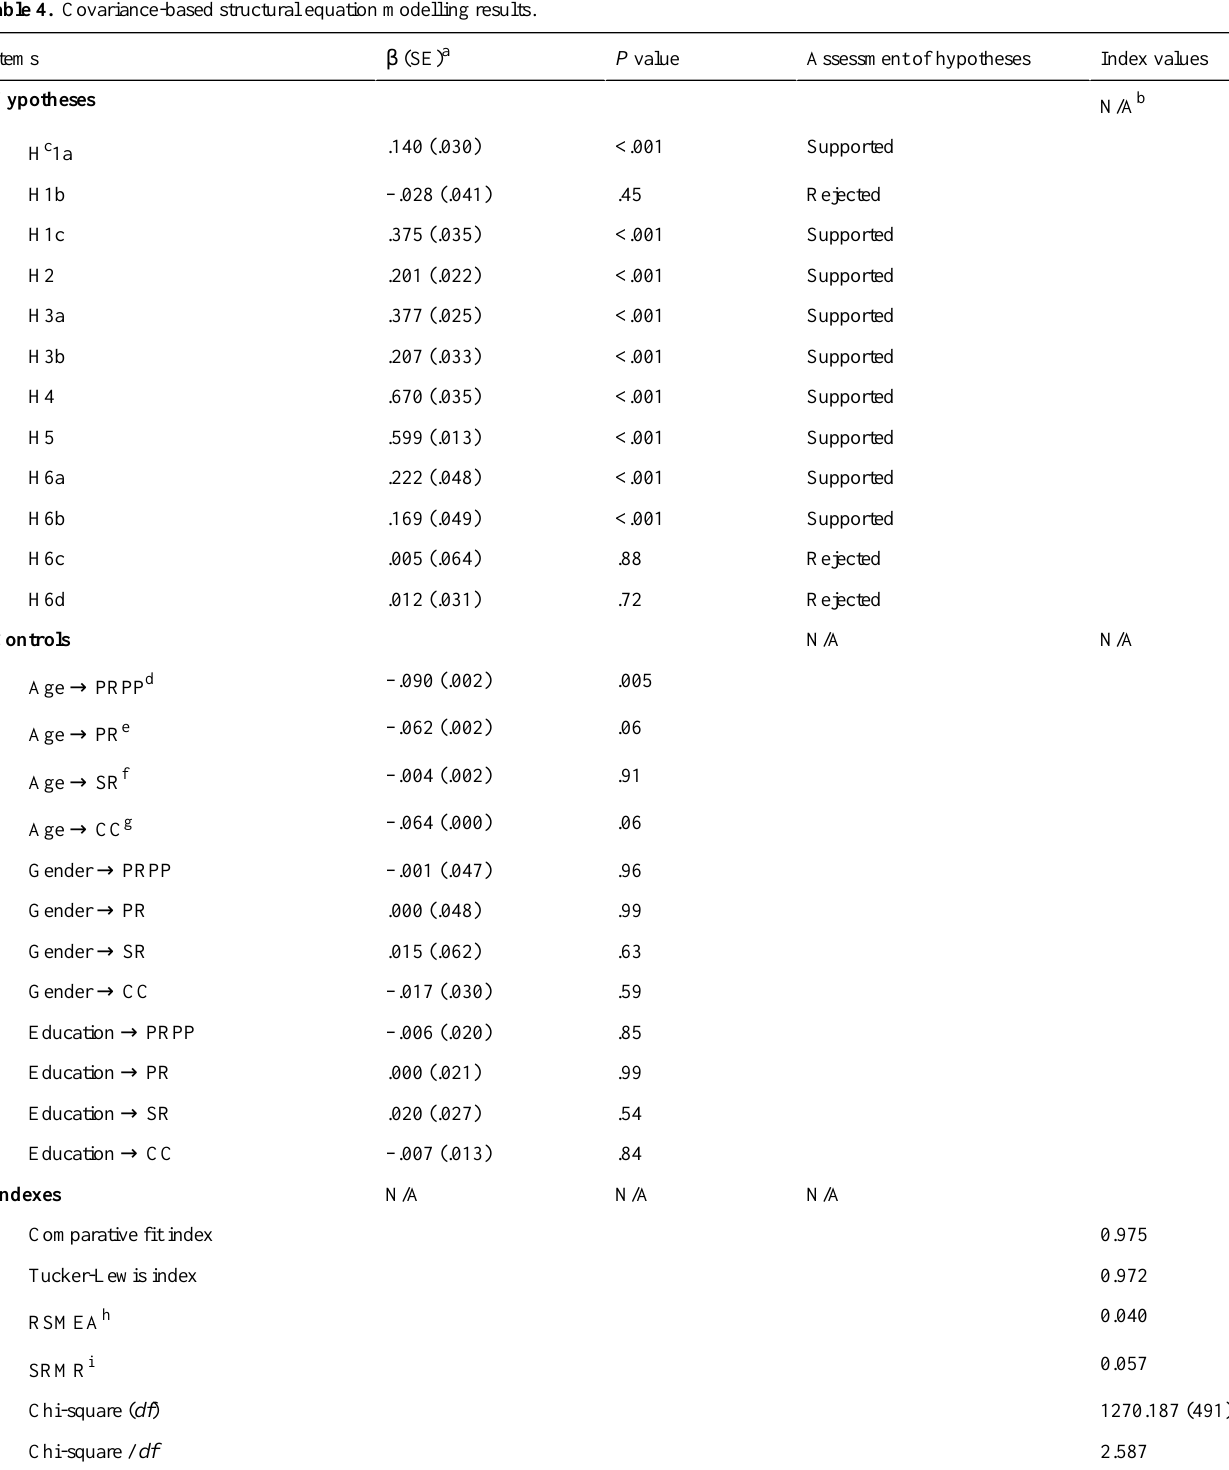
Table 4. Covariance-based structural equation modelling